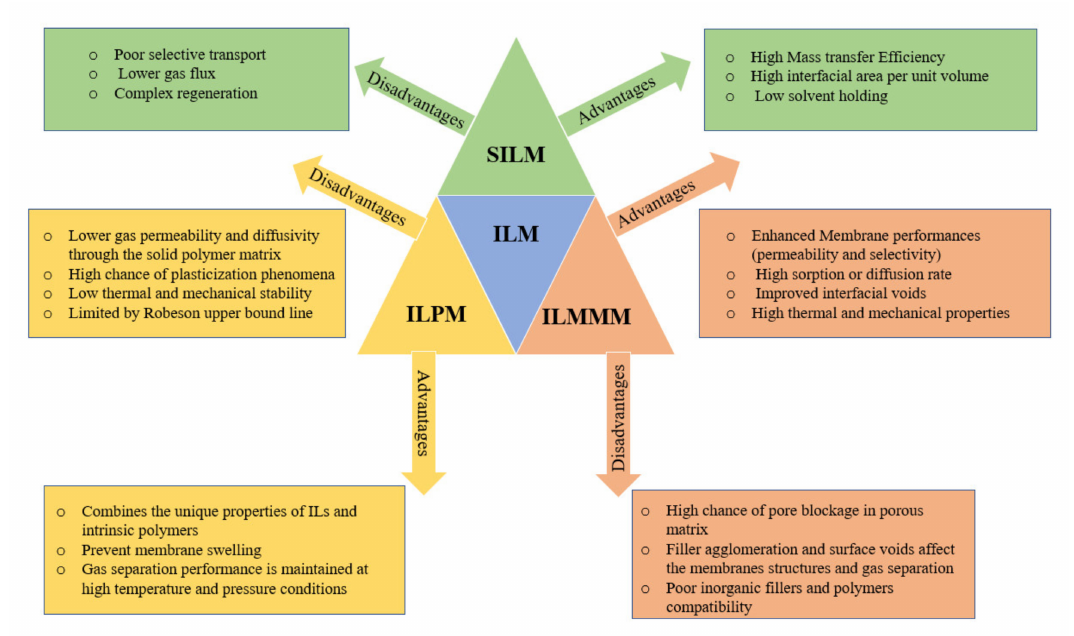
Figure 9. Summary of the advantages and disadvantages of SILM, ILPPM, and ILMMM.